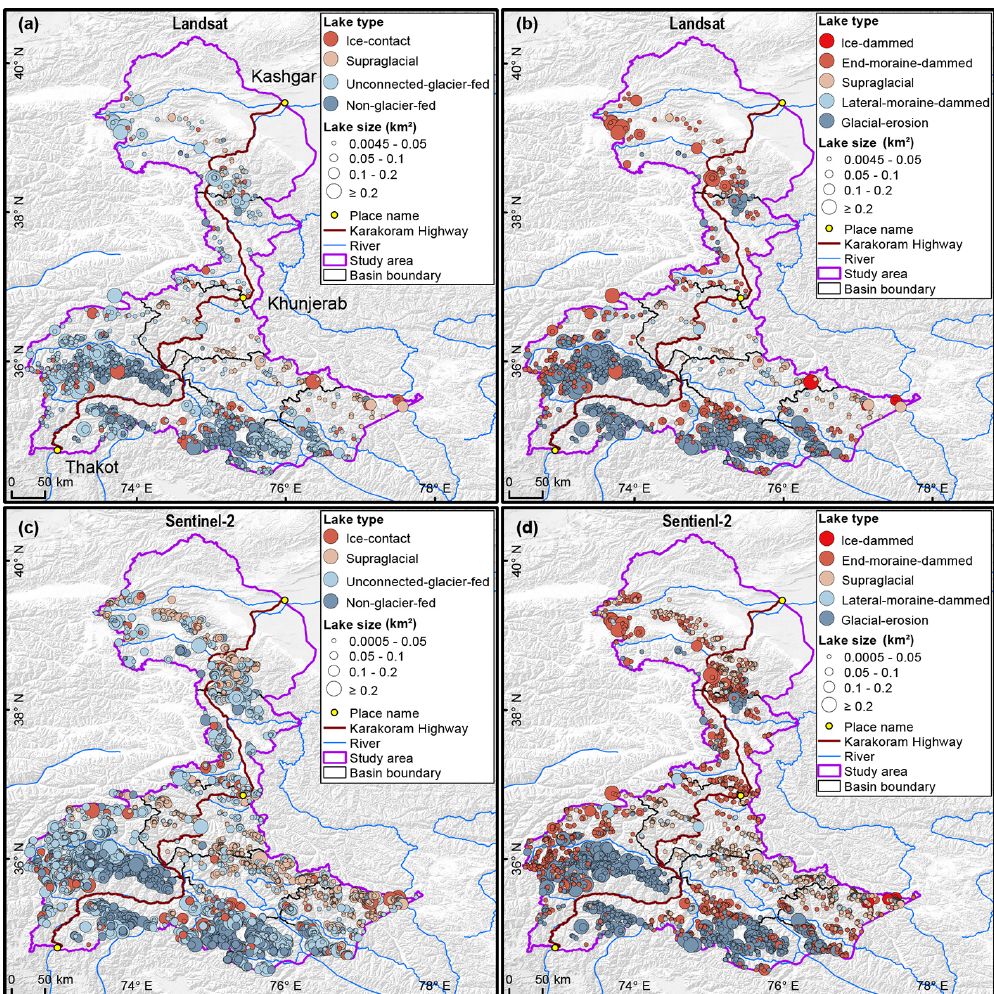
Figure 5. Distribution of glacial lakes in 2020 extracted from Landsat (a, b) and Sentinel-2 (c, d) images. Panels (a) and (c) are classified by GLCS1 and GLCS2 for panels (b) and (d) .